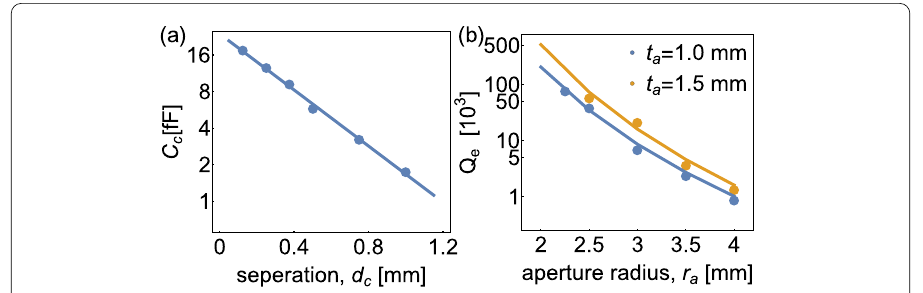
Figure 7 Extraction of coupling strengths for coaxial and waveguide resonators. (a) Coupling capacitance C c (dots) obtained from an ABCD transmission matrix model fit to the measured spectrum versus the distance d c between the center conductors of CC085Cu. The solid line is an exponential fit to the data. (b) Measured Q e of the TE 101 mode of a 3D cavity aperture coupled to a rectangular waveguide. The solid line is obtained from a finite element simulation.